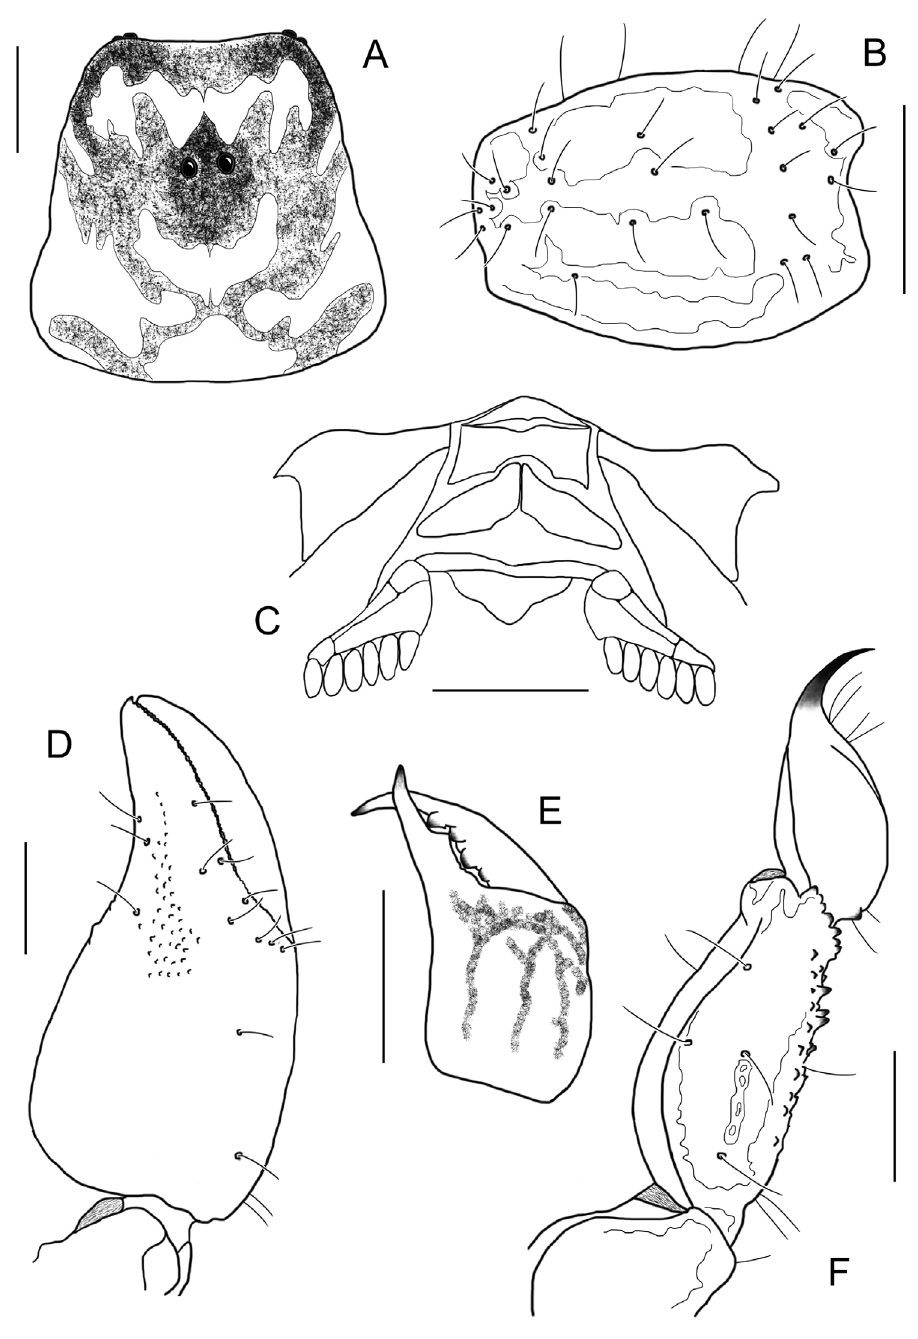
Figure 16. Auyantepuia aluku sp. n. female holotype. A Carapace B Patella, external aspect C Sternum, genital operculum and pectines D Chela, dorso-external aspect E Chelicera F Metasomal segment V and telson, lateral aspect. Scale bars: 1 mm except chelicera 0.5 mm ( E